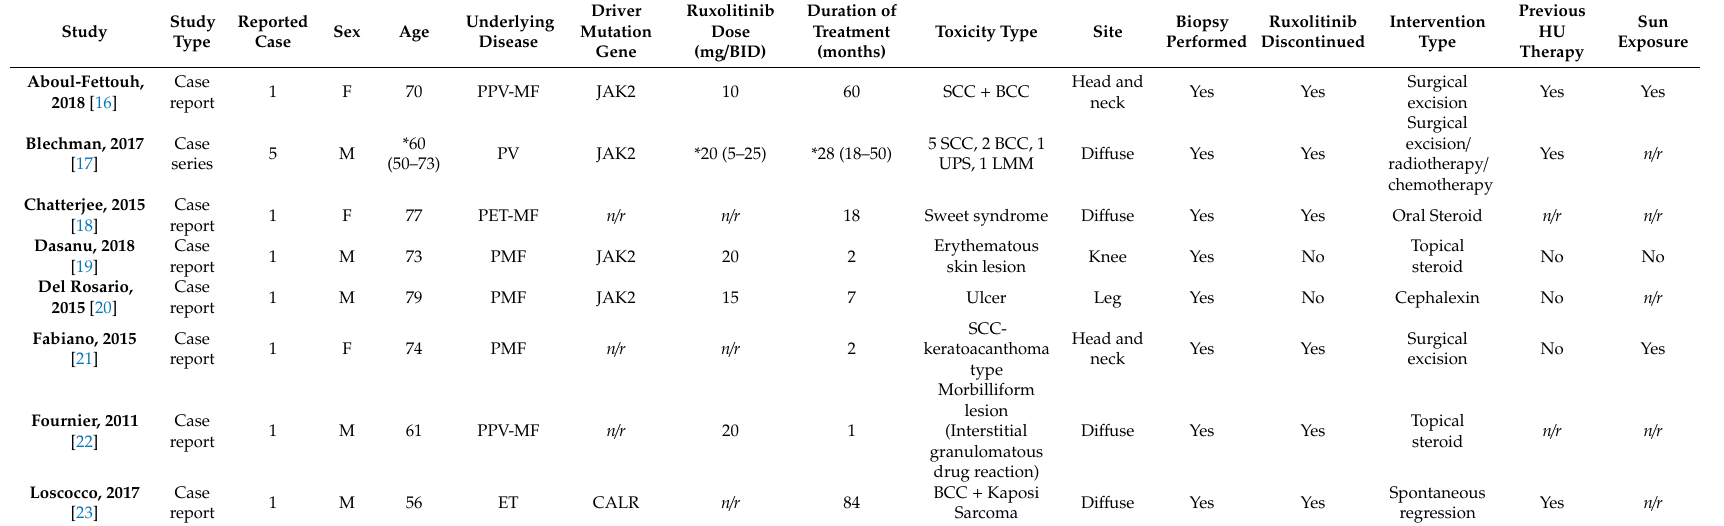
Table 1. Reported cases of ruxolitinib-induced cutaneous